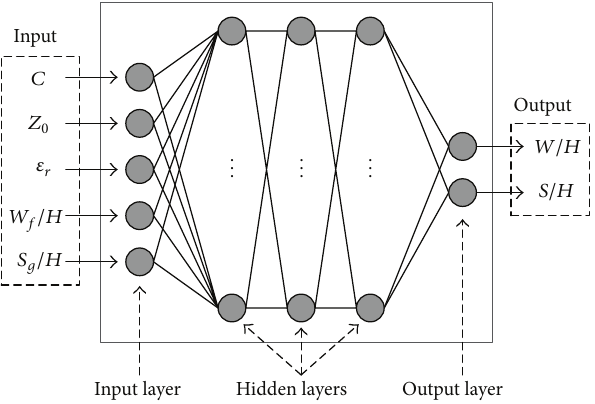
Figure 2: ANN-based synthesis model of the